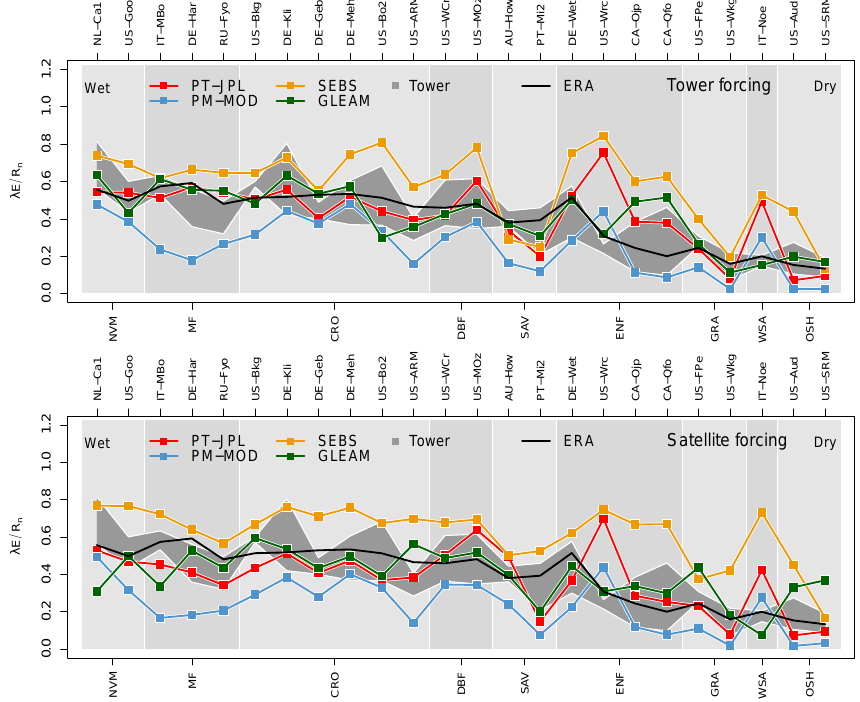
Figure 3. Station means of 3-hourly EC-observed and tower-forced (top panel) and satellite-forced (bottom panel) evaporative fraction against tower reference, as function of biomes, sorted from wet to dry (based on the biome average). The grey area denotes the range of evaporative fraction between EC and ER measurements. The black line denotes EF derived from ERA-Interim ET (ERA) and R n